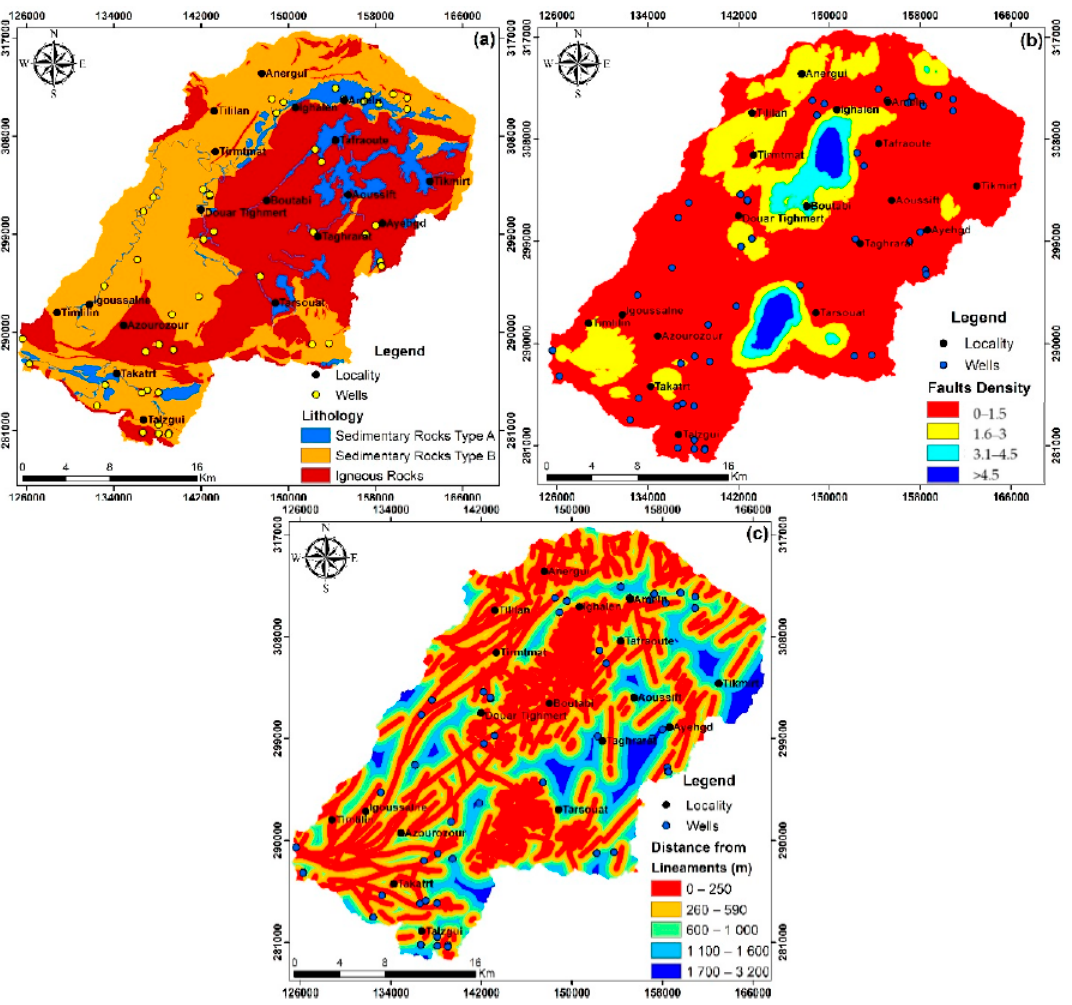
Figure 11. Geological factors influencing groundwater. ( a ) Lithology; ( b ) Lineaments density; ( c ) Distance from lineaments.